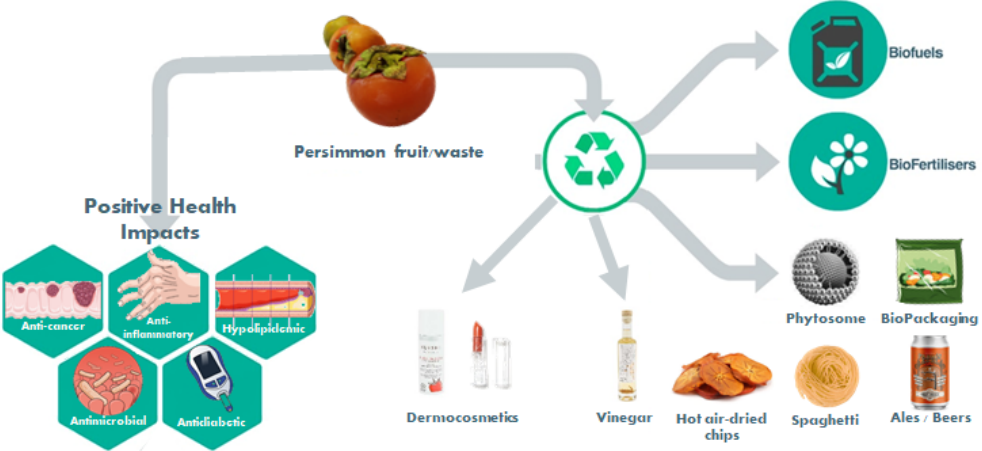
Figure 2. Solutions from the reinvention of old products with persimmon fruit and the addition of byproducts.